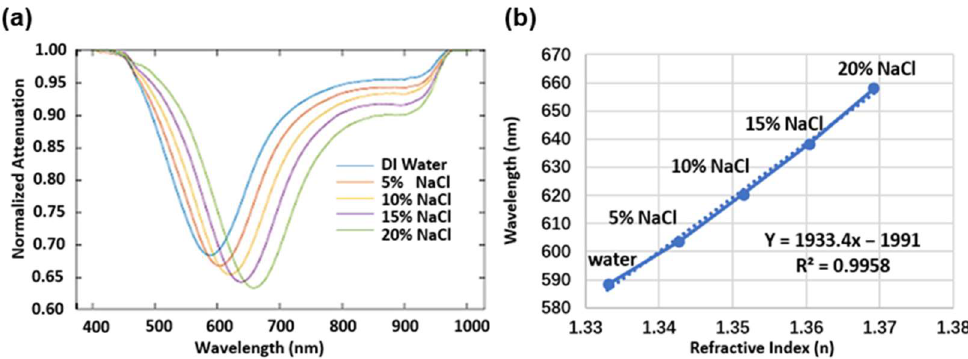
Figure 3. ( a ) SPR spectra obtained for the purposes of measuring NaCl solutions with different concentrations from 0 to 20% ( w / w %) in deionized (DI) water. ( b ) Wavelength values (solid line) of the SPR dip changing with the refractive index of the NaCl solutions [37]. The dash line is the linear fitting of the wavelength values.